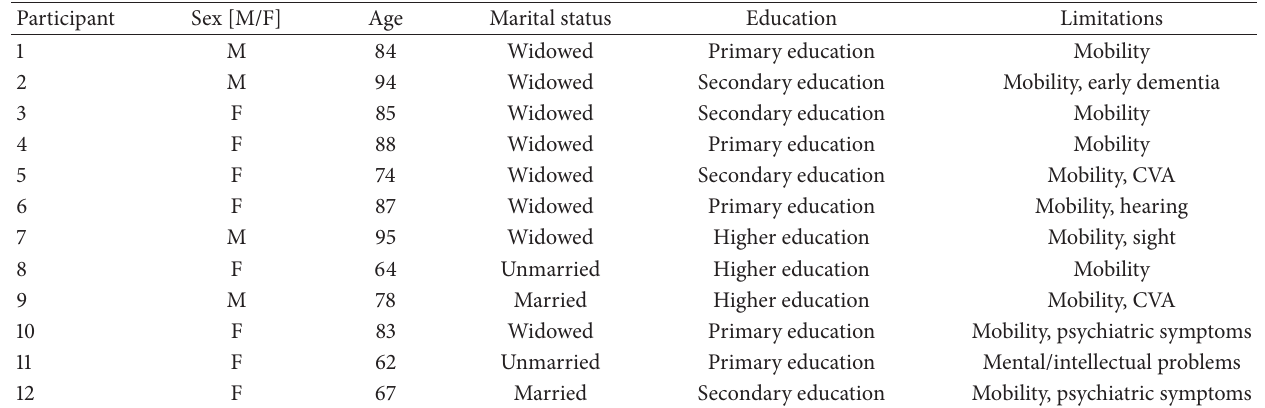
Table 1: Characteristics of the